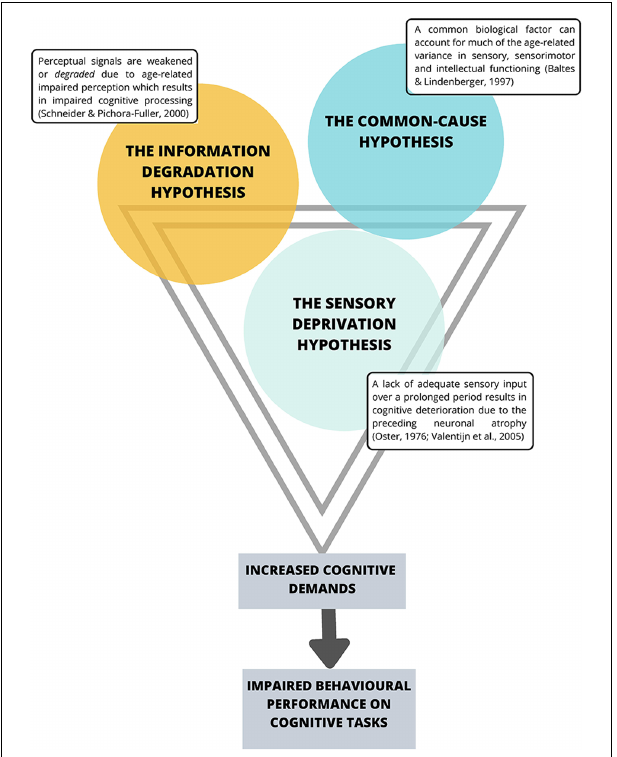
FIGURE 1 | Current theories suggesting an interaction between sensory system decline and impaired cognitive performance. Note that the premises behind these theories share substantial